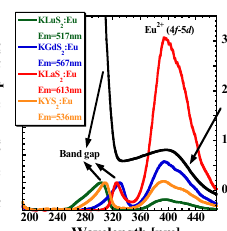
KLuS 2 :Eu Em=517nm KGdS 2 :Eu